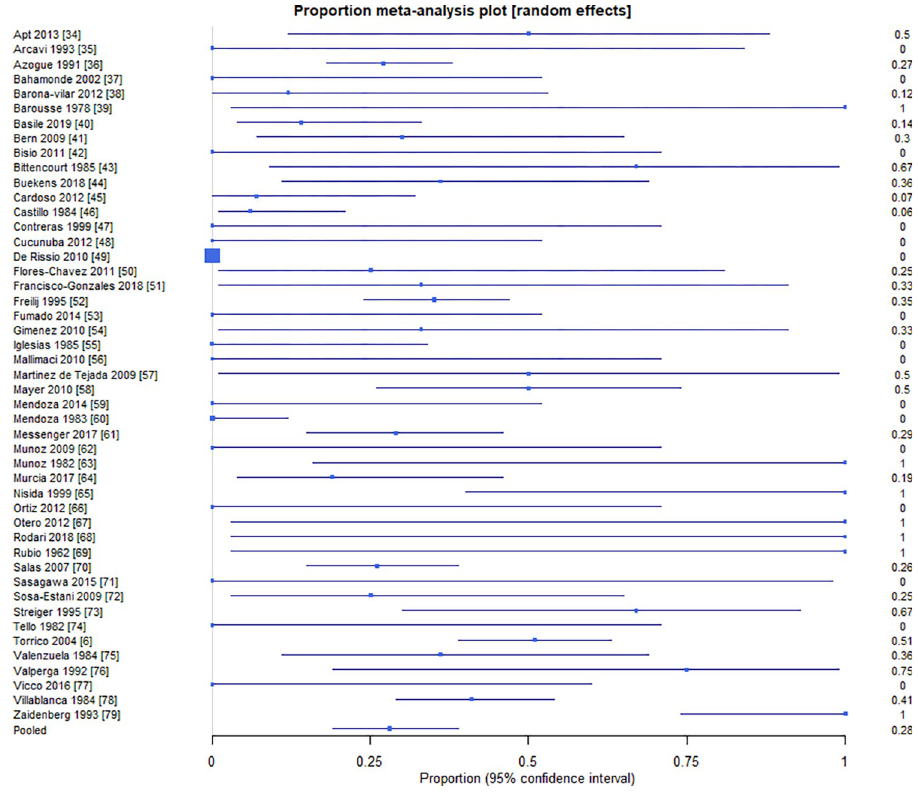
Fig 1. Proportion of infants with cCD who present with morbidity by study [6,34–79].